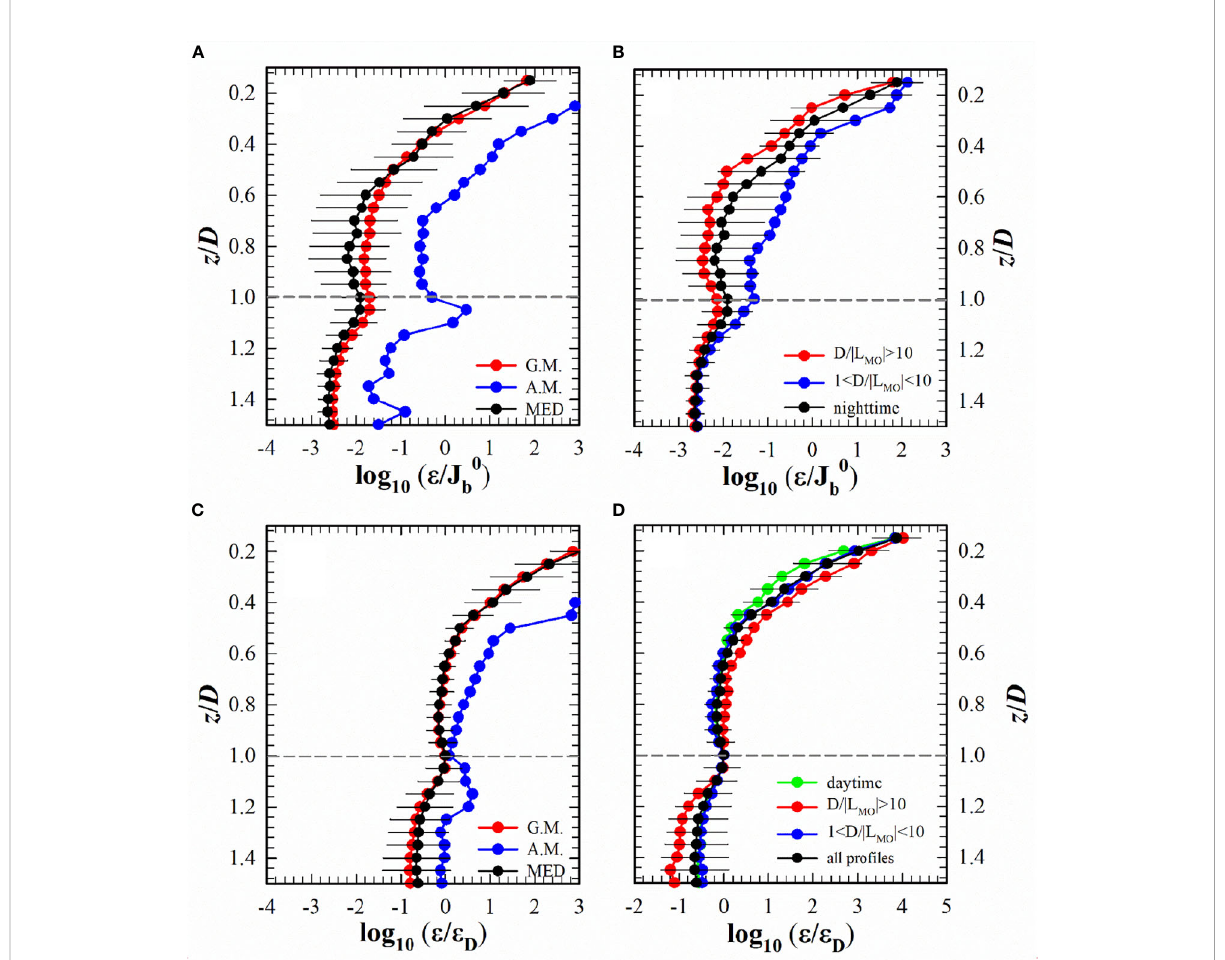
FIGURE 3 (A) ϵ = J 0 b versus z / D in semi-log coordinates using different statistical methods, geometric-mean (G.M.), arithmetic-mean (A.M.), and median (MED), for all nighttime pro fi les. (B) Median ϵ = J 0 b versus z / D for all nighttime pro fi les (black) and for nighttime pro fi les with D /| L MO | > 10 (red) and 1< D /| L MO |< 10 (blue). (C) ϵ / ϵ D versus z / D in semi-log coordinates using different statistical methods for all pro fi les. (D) Median ϵ / ϵ D versus z / D for all pro fi les (black), daytime pro fi les (green), and nighttime pro fi les with D /| L MO | > 10 (red) and 1< D /| L MO |< 10 (blue). The error bars, only draw representatively on one pro fi le, denote the 50% con fi dence intervals. The vertical dashed lines in (A, B) denote ϵ = J 0 b =0.58 proposed in Lombardo and Gregg (1989). The horizontal dashed lines in (A – D) denote z =